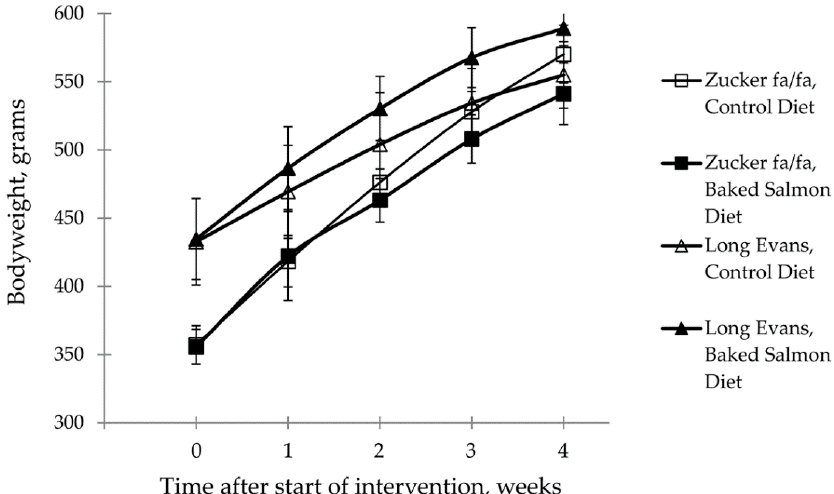
Figure 1. Bodyweight development (grams) in obese Zucker fa/fa rats and Long-Evans rats, shown as mean values with standard deviations, for n = 5 in Zucker fa/fa Control Group, and n = 6 in all other groups. No differences were seen at any time points within any of the rat strains. p < 0.05 was considered significant. Groups within rat strains are compared using Independent Samples T Test assuming equal variances.